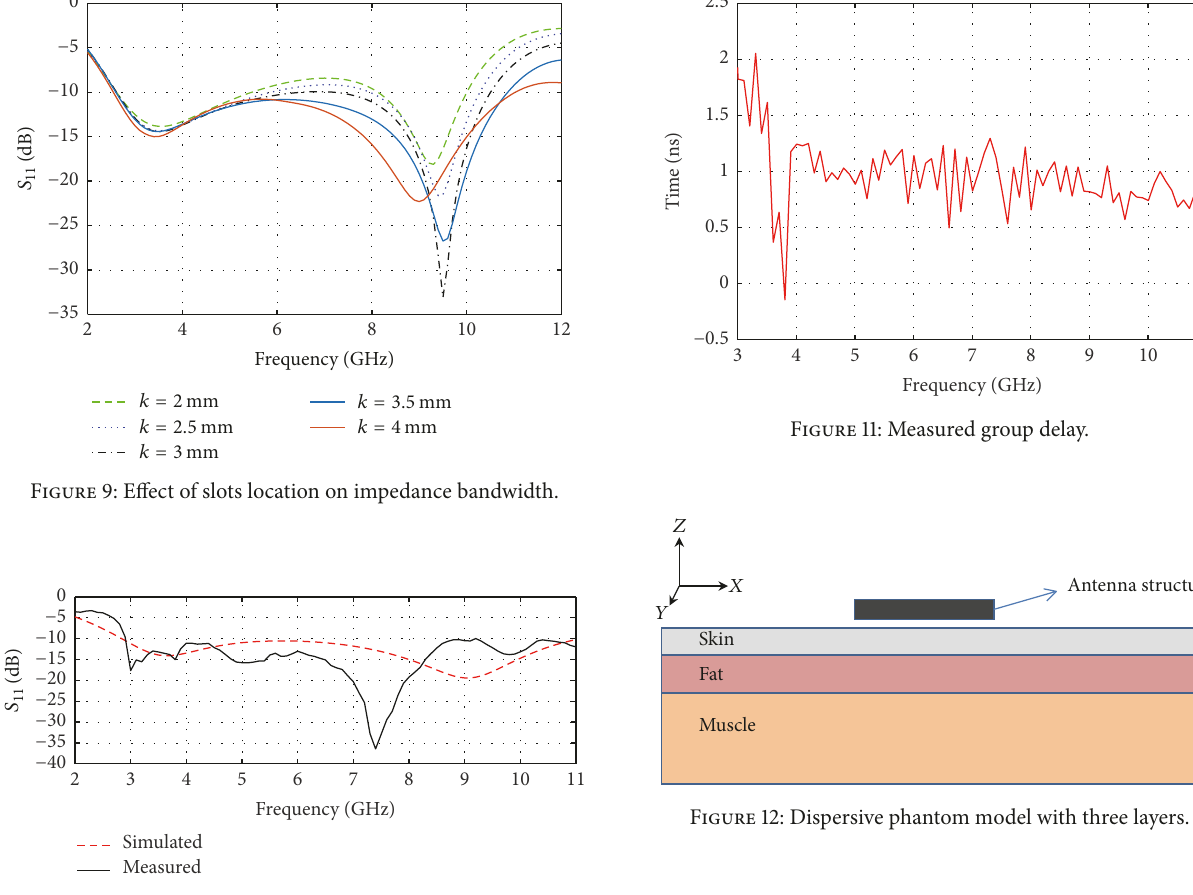
Figure 10: Simulated and measured reflection coefficients of PM antenna.